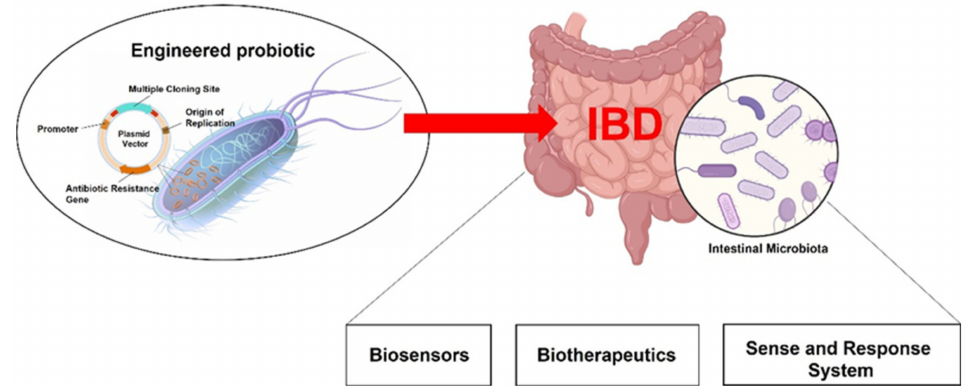
Figure 1. Live biotherapeutics as new treatments for inflammatory intestinal diseases. Advances in the use of probiotics led to the development of engineered bacteria that act as intestinal biosensors, which detect specific biomarkers and work as diagnostic tools, and/or drug delivery systems able to release therapeutic substances directly into the intestinal lumen. Plasmids are the major vector for inducing recombinant DNA expression into desired probiotic strains. Despite diverse plasmids encoding for immunoregulatory cytokines, reporter substrate, or anti-inflammatory mediators being engaged in probiotics bioengineering, distinct regions are generally recognized: DNA replication ori- gin, an antibiotic resistance gene, and the “Multiple Cloning Site” where exogenous DNA fragments are inserted by restriction